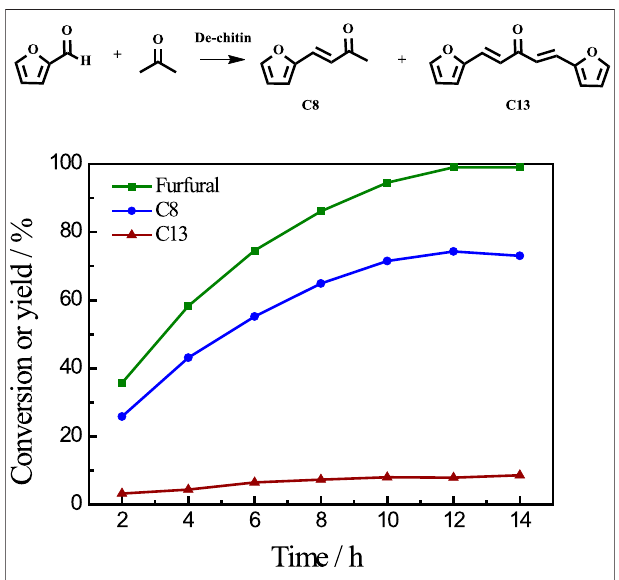
FIGURE 3| Time conversion plot for the reactionof furfural with acetone over De-chitin as solid base catalyst. Reaction conditions: furfural 0.48 g, acetone 1.16 g, catalyst 0.1 g, 140 ° C.